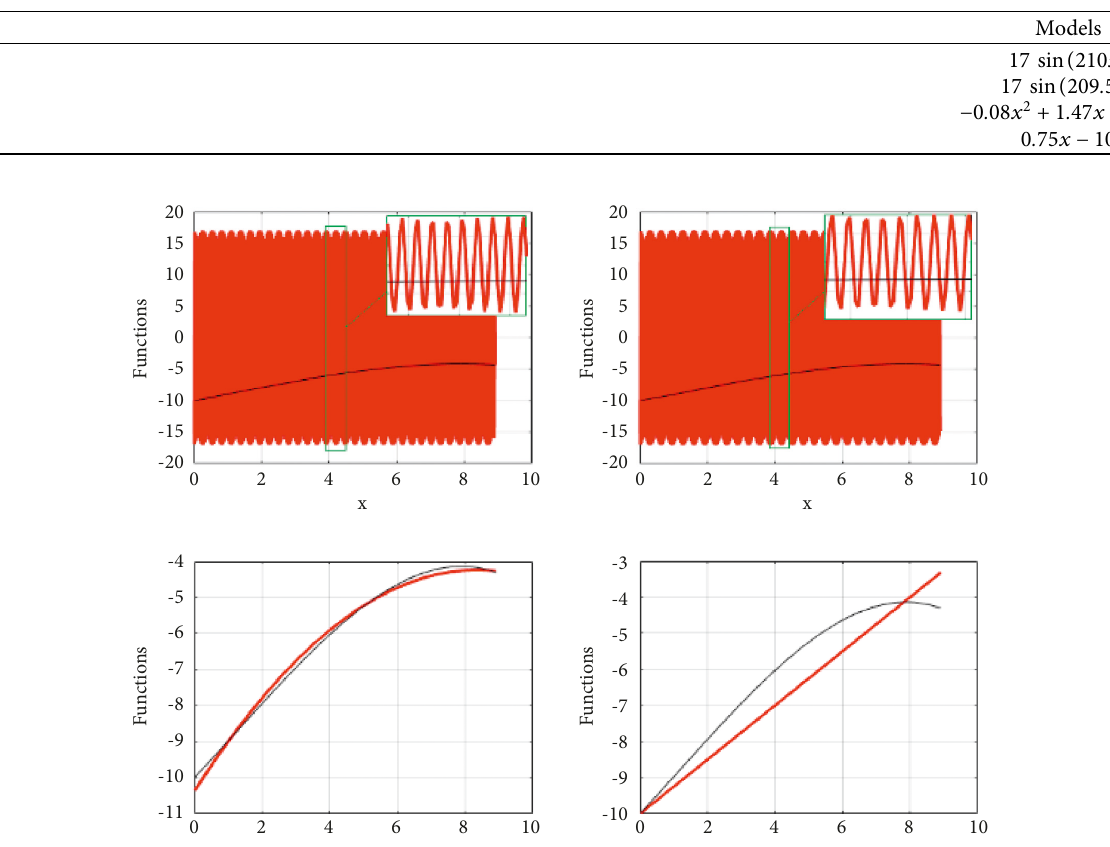
Figure 1: Black: the original data generated with (14). Red: the models of Table 1. From top left to bottom right models from 1 to 4.